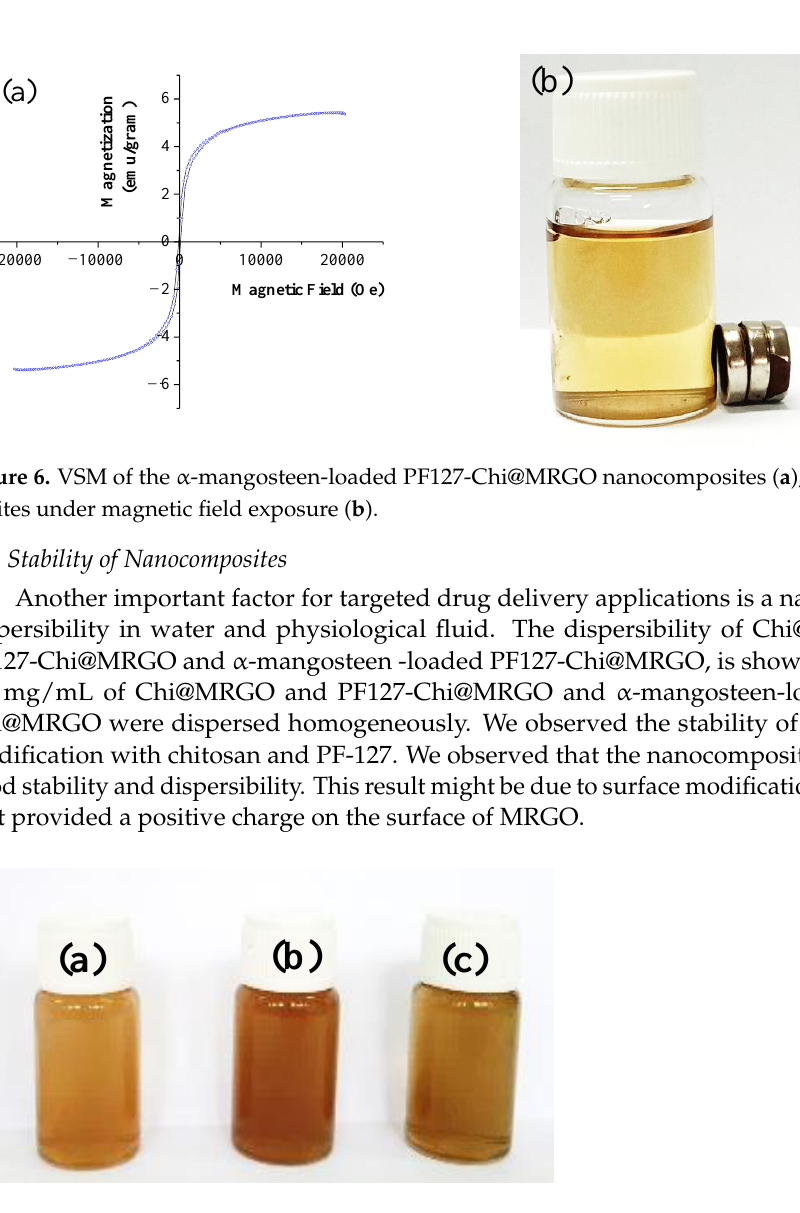
Figure 7. Stability of Chi@MRGO ( a ); PF127-Chi@MRGO ( b ); α -mangosteen-loaded PF127- Chi@MRGO ( c ).